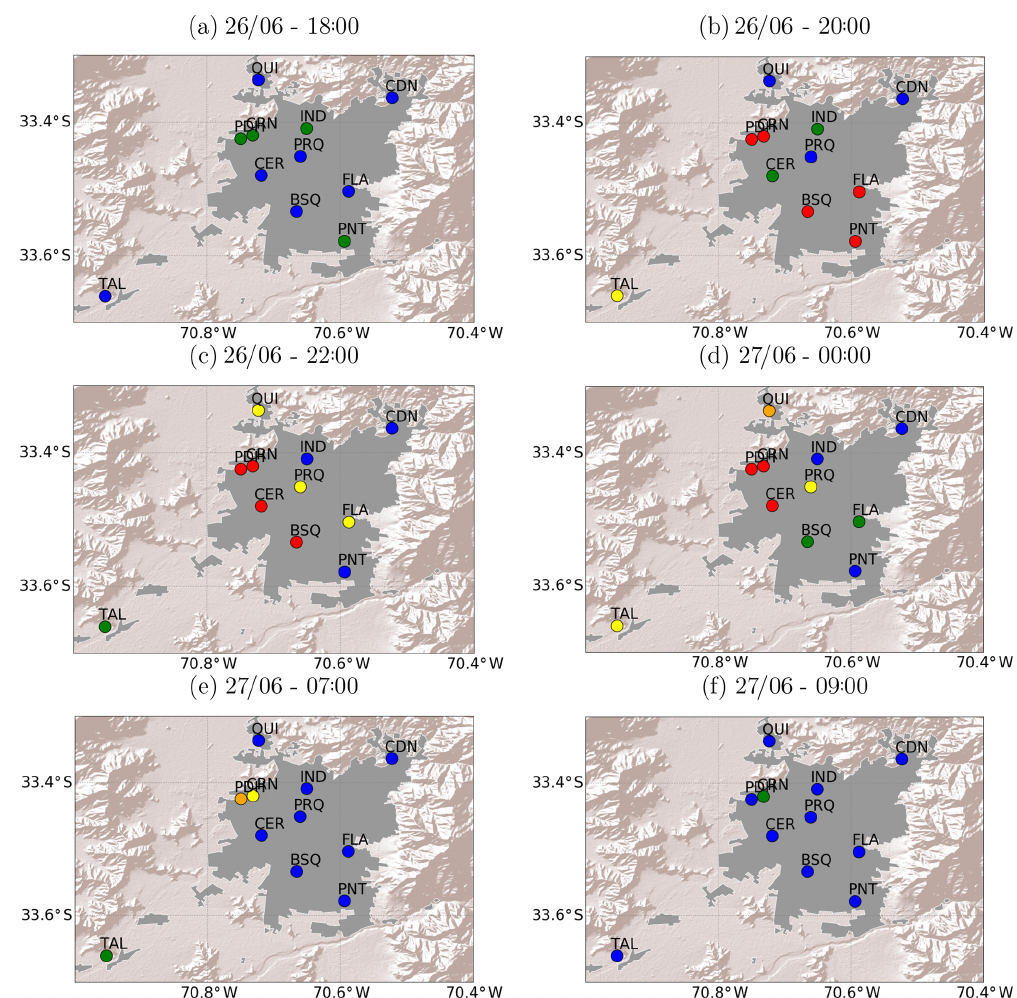
Figure 4. Observed PM 2 . 5 hourly concentrations during the peak on 26 June compared to its average over summer 2016 – blue ≤ 200%, green ≤ 300%, yellow ≤ 400%, orange ≤ 500%, red > 500%. Map background layer: World Shaded Relief, © 2009